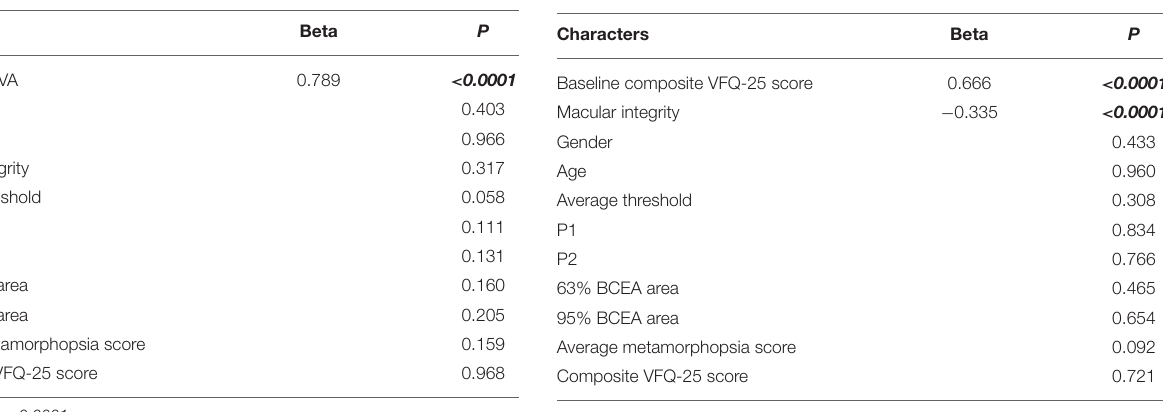
TABLE 7 | Multiple linear regression model to evaluate the factors associated with the final composite VFQ-25 score.